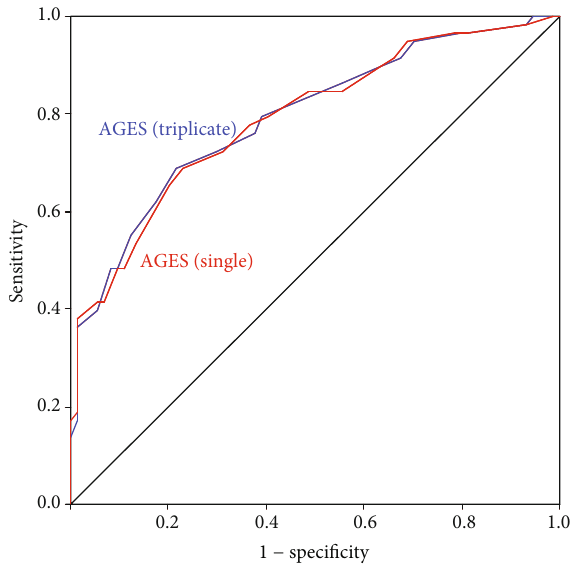
Figure 3: ROC analysis for the evaluation of the diagnostic signi fi cance of AGEs (single measurement) and AGEs (triplicate measurement) for overall